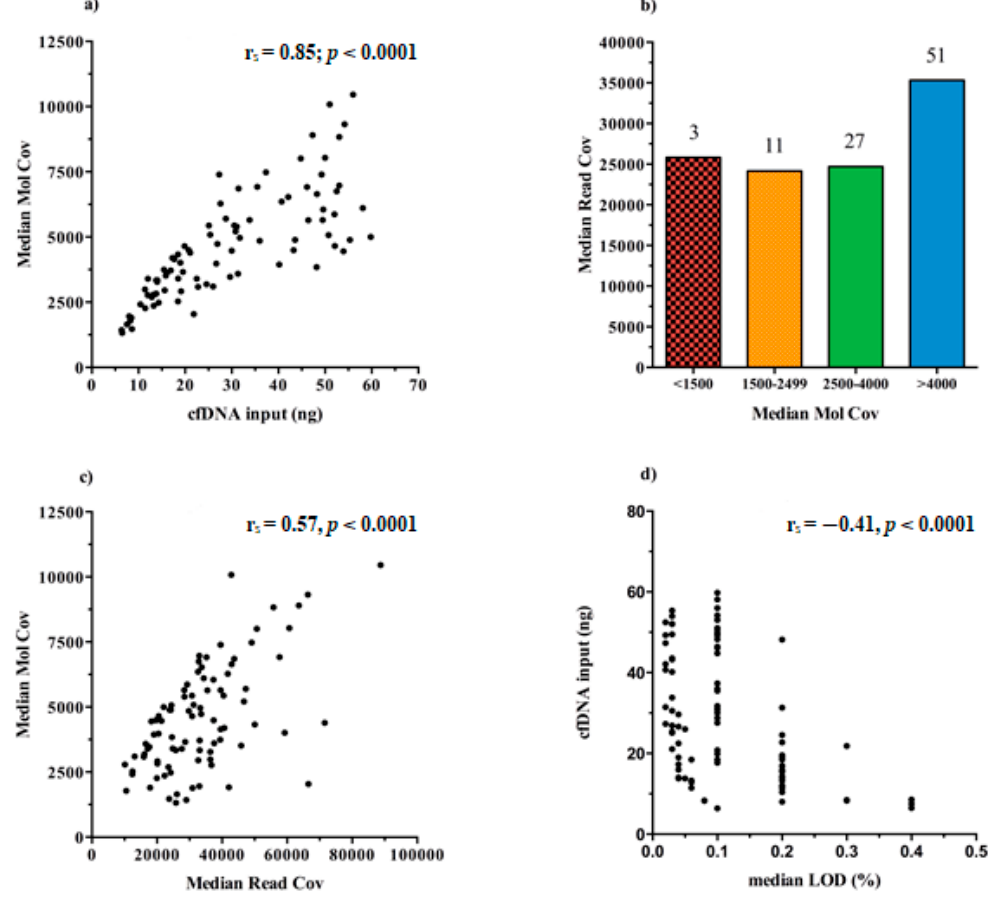
Figure 4. Graphical representation of the Ion Torrent Suite ™ Software (TSS) sequencing data about libraries performance in all samples (n = 92). ( a ) Scatter plot of the positive correlation between the cfDNA input and the median number of DNA molecules tagged (MedMolCov) (r s = 0.85; p < 0.0001). ( b ) Bar chart of the MedMolCov values divided into four ranges ( < 1500, 1500–2499, 2500–4000, > 4000) and the relative MedReadCov values. ( c ) Scatter plot of the positive correlation between the MedReadCov and the Median Mol Cov (r s = 0.57, p < 0.0001). ( d ) Scatter plot of the negative correlation between the median LoD values of each library and the initial cfDNA input (r s = − 0.41, p < 0.0001).